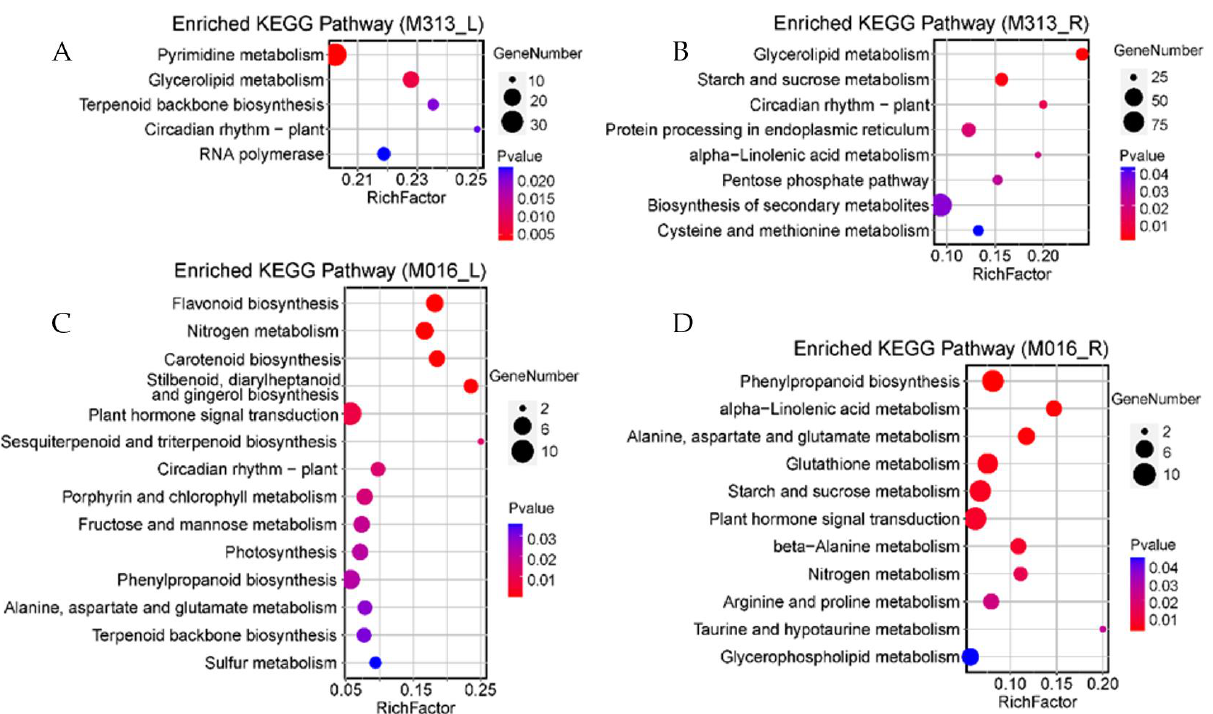
Figure 4. KEGG enrichment pathways of up-regulated genes in leaves and roots of diploid and tetraploid M. lutarioriparius . ( A ) Pathway enrichment in leaves of M313. ( B ) Pathway enrichment in roots of M313. ( C ) Pathway enrichment in leaves of M016. ( D ) Pathway enrichment in roots of M016. The color of the dots represents p-value, and the size of the dots represents the number of enriched genes.